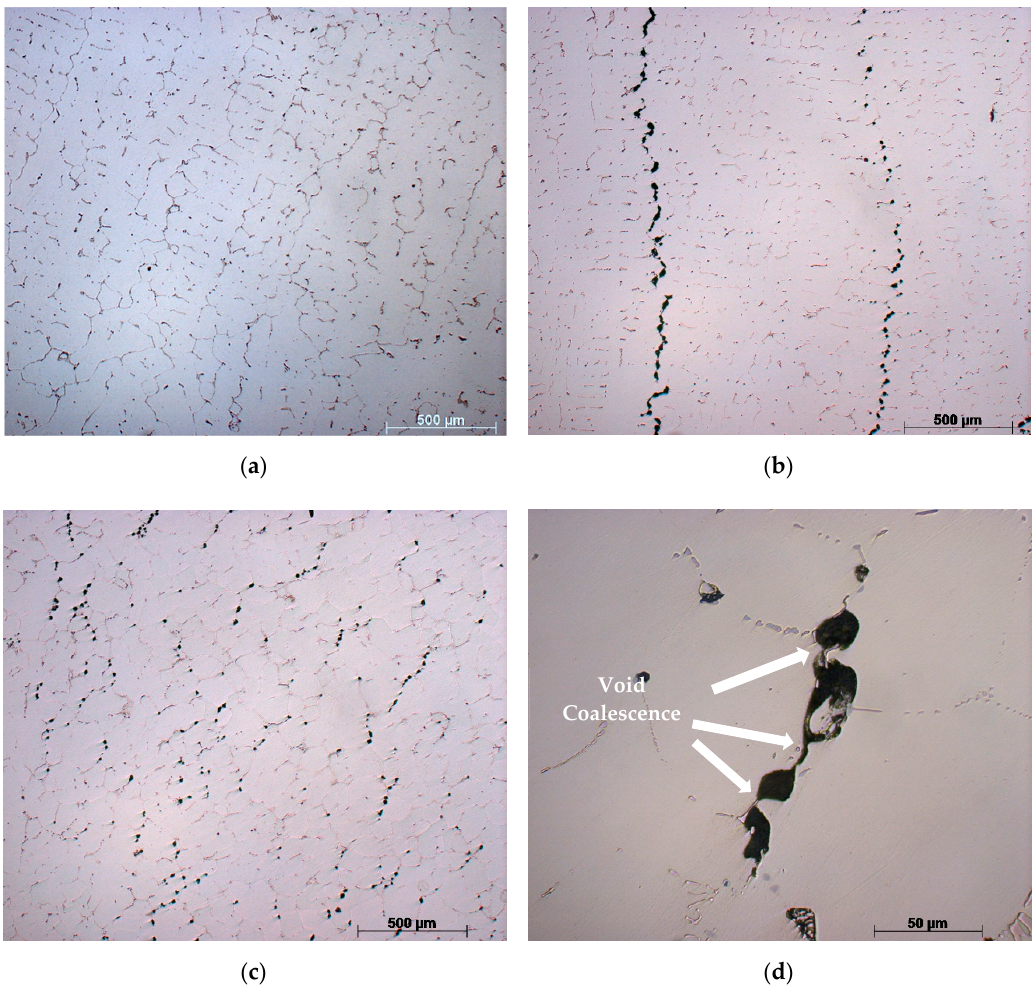
Figure 4. ( a ) The as-cast microstructure and voids in failed samples in ( b ) the dendritic structure region and ( c , d ) the equiaxed grain region .